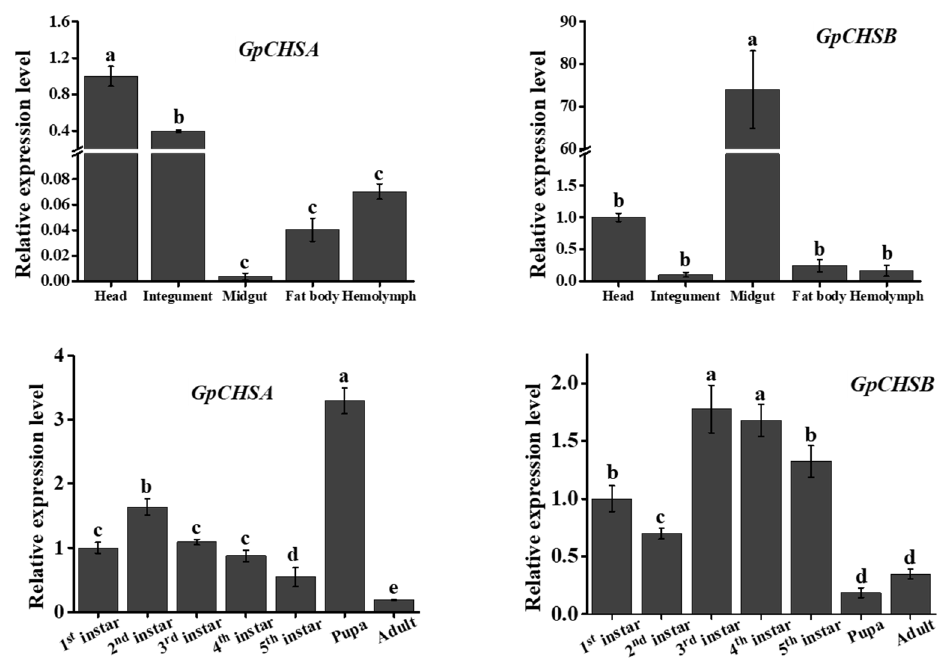
Figure 4. Analysis of GpCHSA and GpCHSB expression in different developmental stages and tissues of fifth instar larvae using RT-qPCR. GpRpl32 was used to normalize the data that are showed as mean ± standard error, the mean is the triple independent repeats. The 2 − ∆∆ C t method was adopted to calculate the relative expression level. Differences among triple repeats were analyzed using one-way analysis of variance (Systat, Inc., Evanston, IL) with Tukey’s post-hoc test using R version 4.0.0. Different letters (a, b, c, d, e) represent significant difference ( p < 0.05).